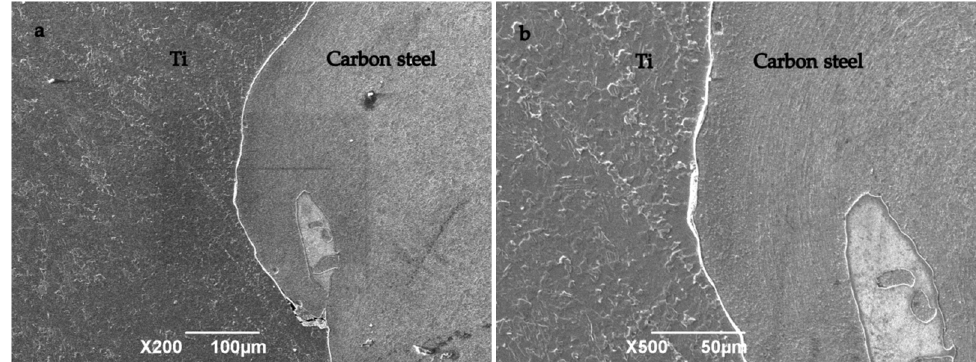
Figure 3. Interface microstructure of the clad plate (SEM): ( a ) low magnification; ( b ) high magnification.